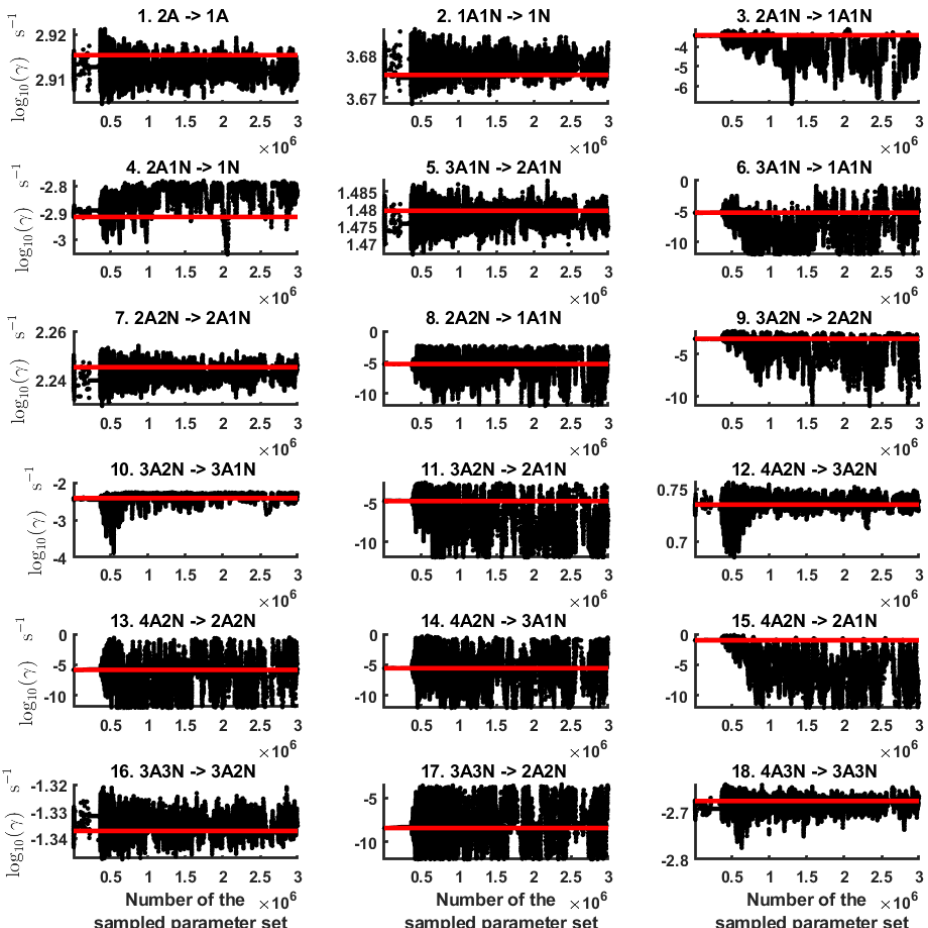
Figure B1. Parameter chains (for parameter indexes ranging from 1 to 18) of the base 10 logarithm of the evaporation rates (units given in s − 1 ) determined from steady-state cluster concentration measurements at the temperature 278K. Red lines denote the baseline values from Olenius et al. (2013b) used to generate the synthetic data. The notation xAyN corresponds to a cluster with x sulfuric acid and y ammonia